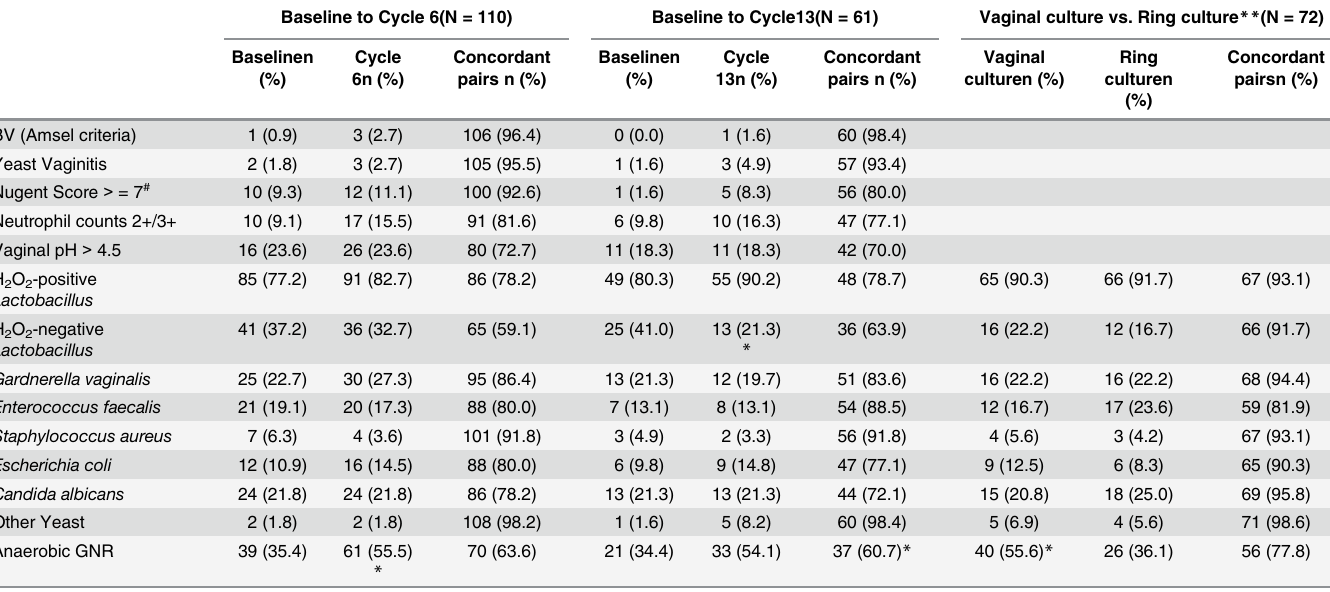
Table 2. Change in vaginal infections and selected vaginal microbiota by assessment visit and the comparison of vaginal culture and ring culture.